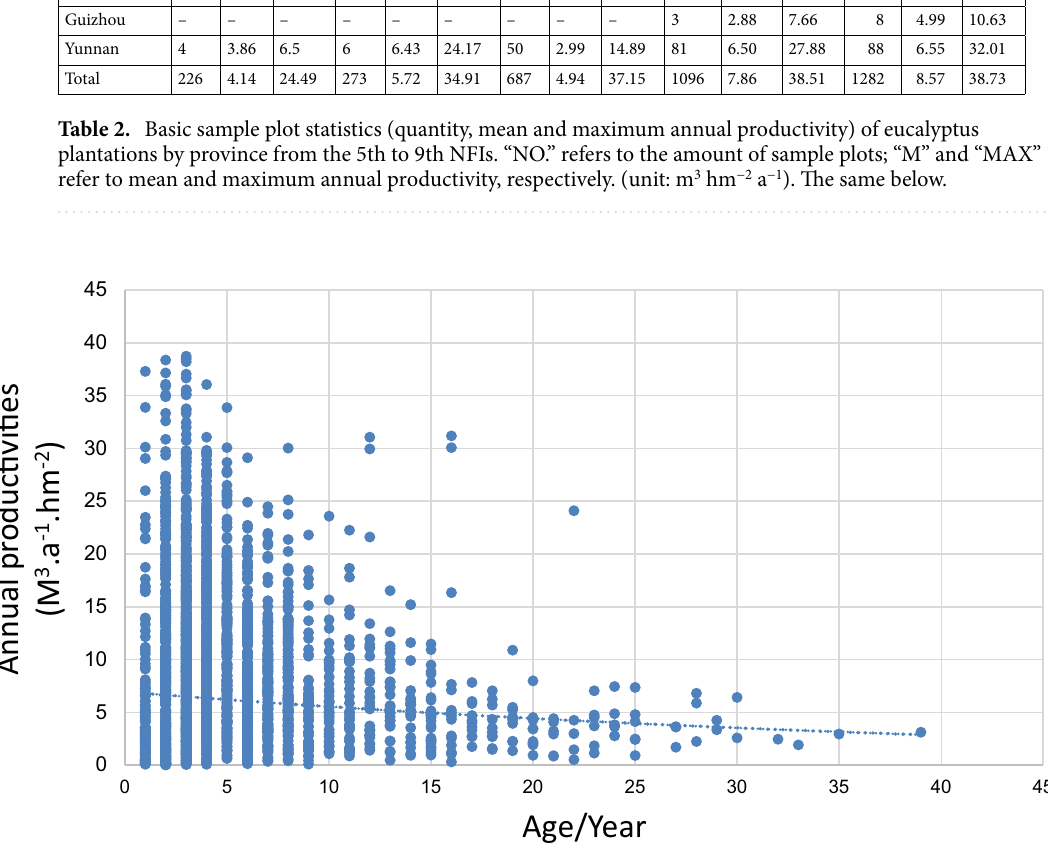
Figure 3. Relationship between age and productivity of eucalyptus sample